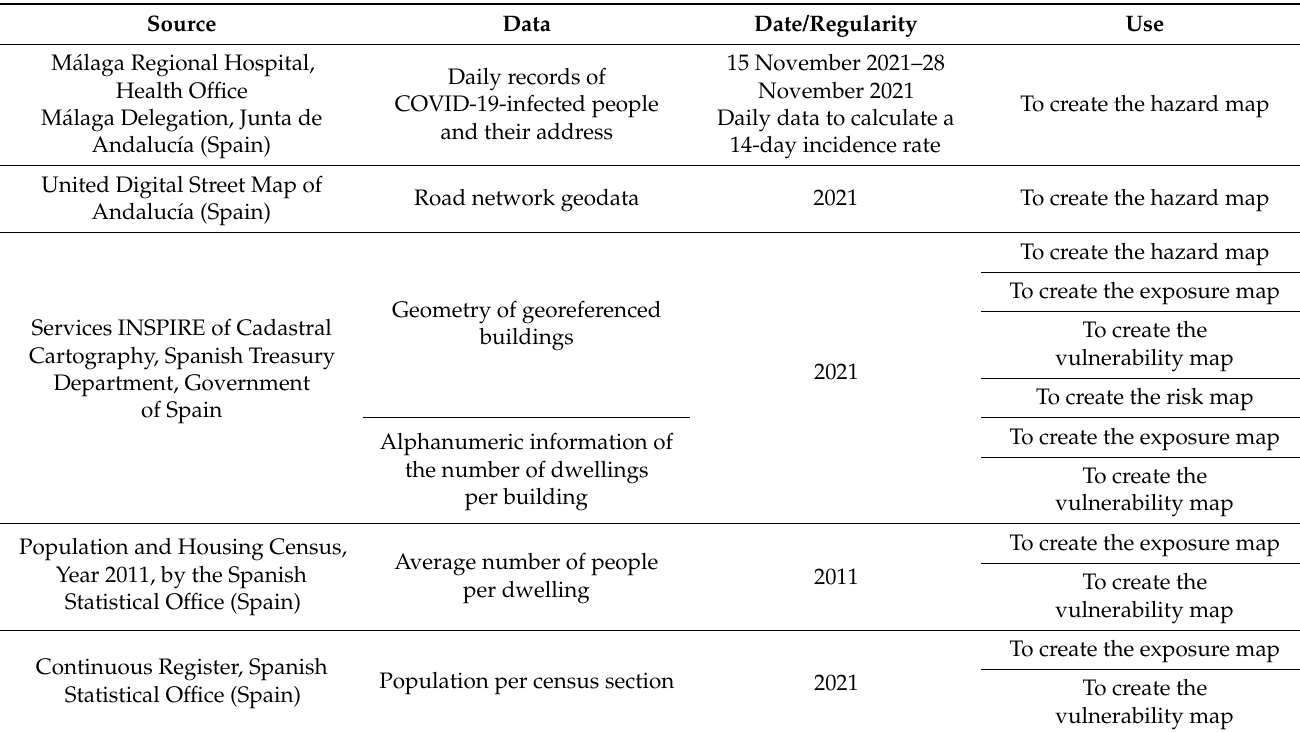
Table 5. Sources of information and its use.